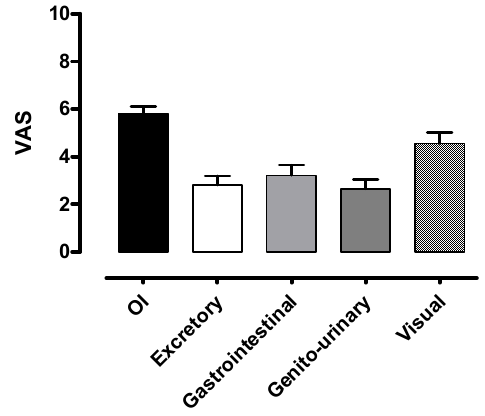
Figure 2. Autonomic symptom assessment at baseline by modified VAS. OI indicates orthostatic intolerance; Excretory, excretory function; Gastrointestinal, gastrointestinal function; Genito-urinary, genito-urinary function; Visual, visual acuity. Results are expressed as mean ± SD.